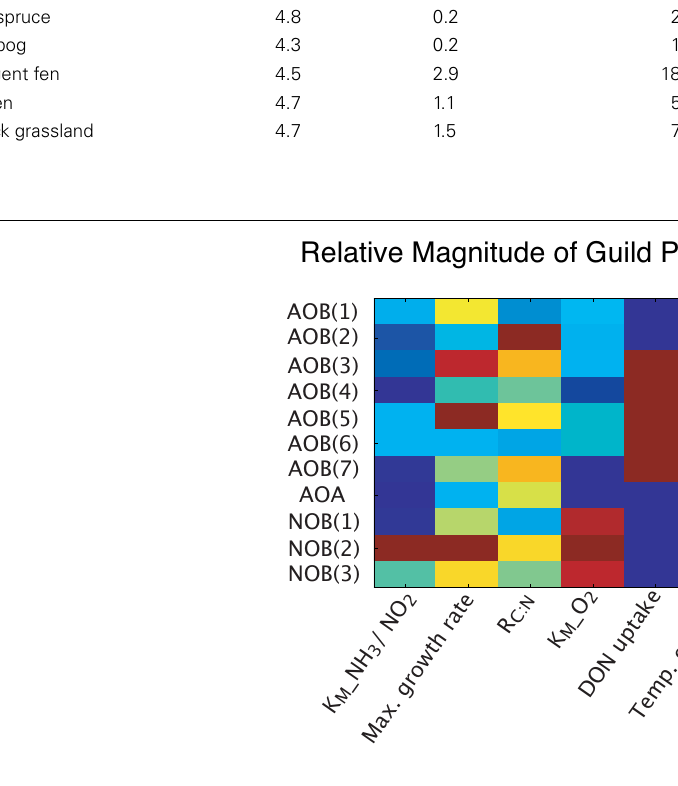
FIGUREA1 | Relative magnitude of guild parameters.